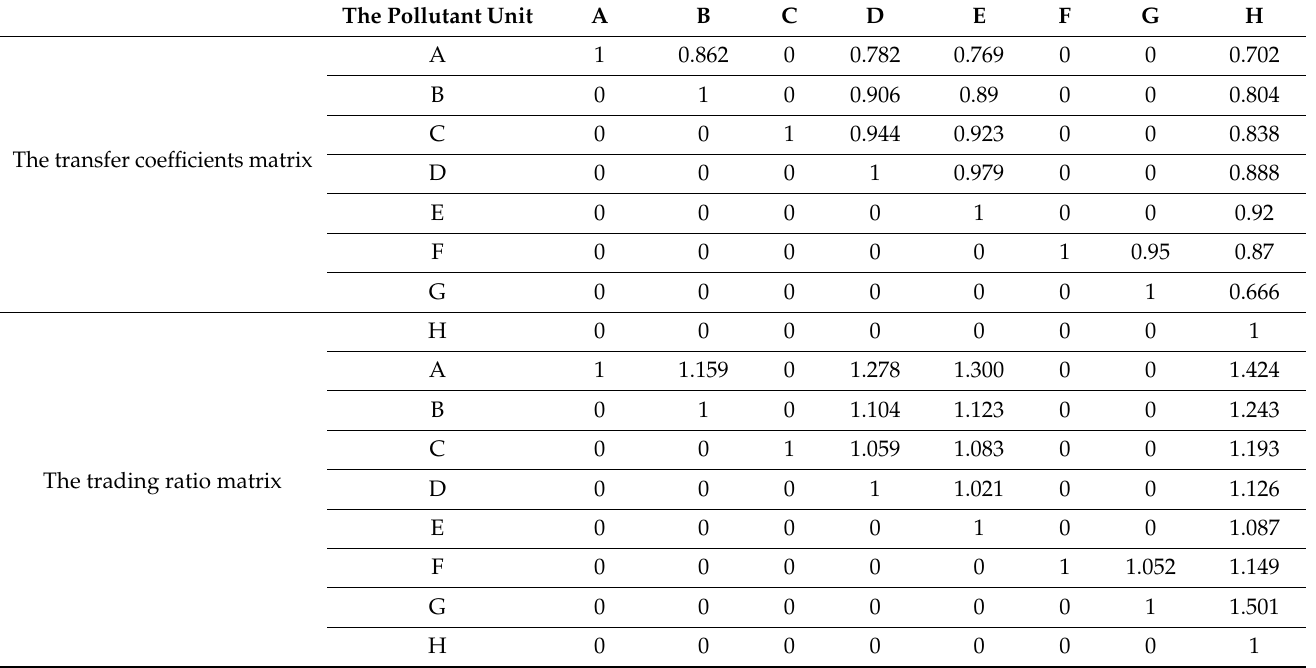
Table 2. The transfer coefficients matrix.